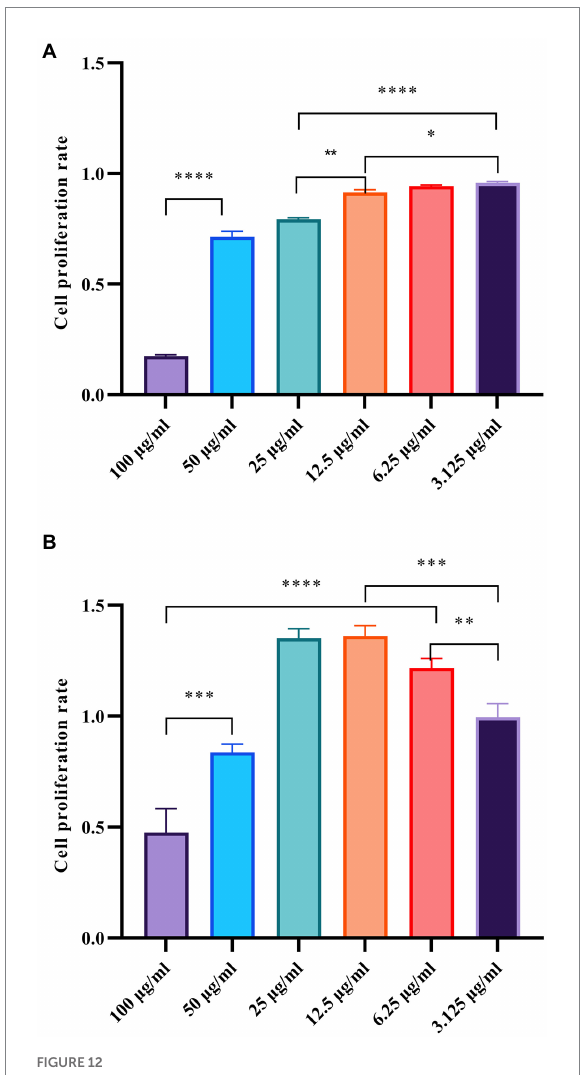
FIGURE 12 Cytotoxicity of AgNPs on CFPAC1 and HFS cells was determined by MTT assay. The panels (A, B) refer to the cell proliferation ratio of CFPAC1 and HFS cells under AgNP treatment for 24 h,